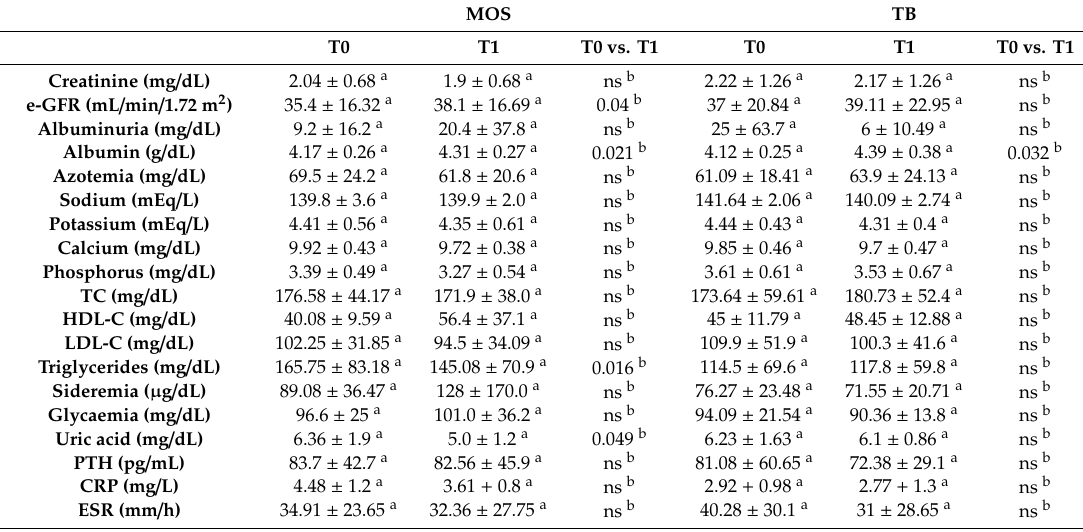
Table 5. Laboratory parameters of Moraiolo (MOS) and TB